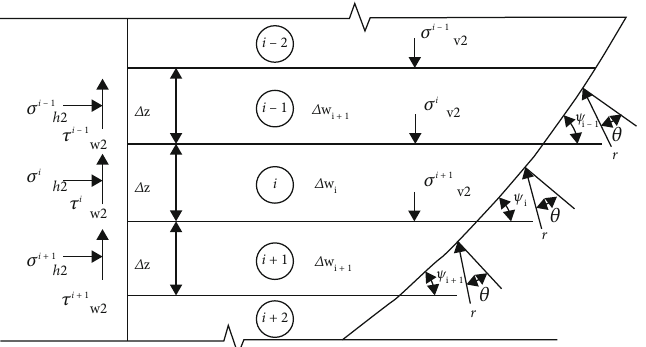
Figure 6: Stress of horizontal di ff erential element layers.